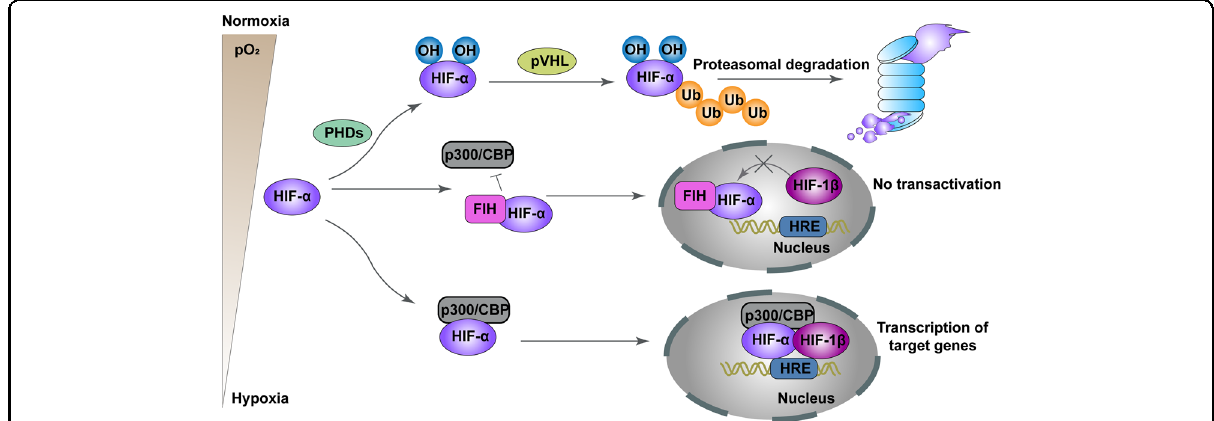
Fig. 1 Schema of regulation of HIF- α degradation and transcriptional activity. Under conditions of normoxia, HIF-1 α and HIF-2 α are continuously degraded through the key oxygen sensor PHD1 – 3, especially PHD2 which enables HIF- α to bind to the pVHL. FIH also inhibits HIF- α by binding to HIF- α and impeding thecombination of HIF- α to the transcriptional coactivators CBP and p300. Under hypoxic conditions, the hydroxylation of HIF α is restrained, leading to stabilization of HIF- α . Next, HIF- α dimerizes with HIF-1 β to comprise a transcriptional activation complex, which binds to HRE and stimulates the transactivation of target genes.